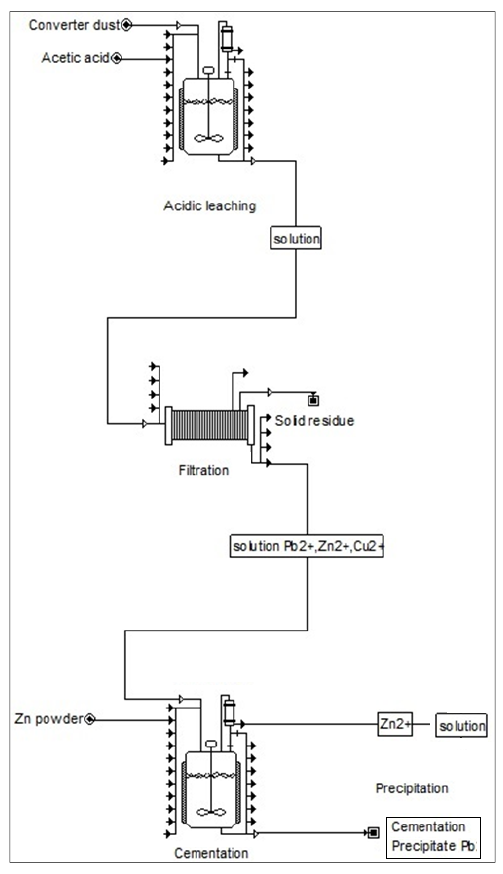
Figure 9. Suggested flowsheet for copper convert dust recycle process.